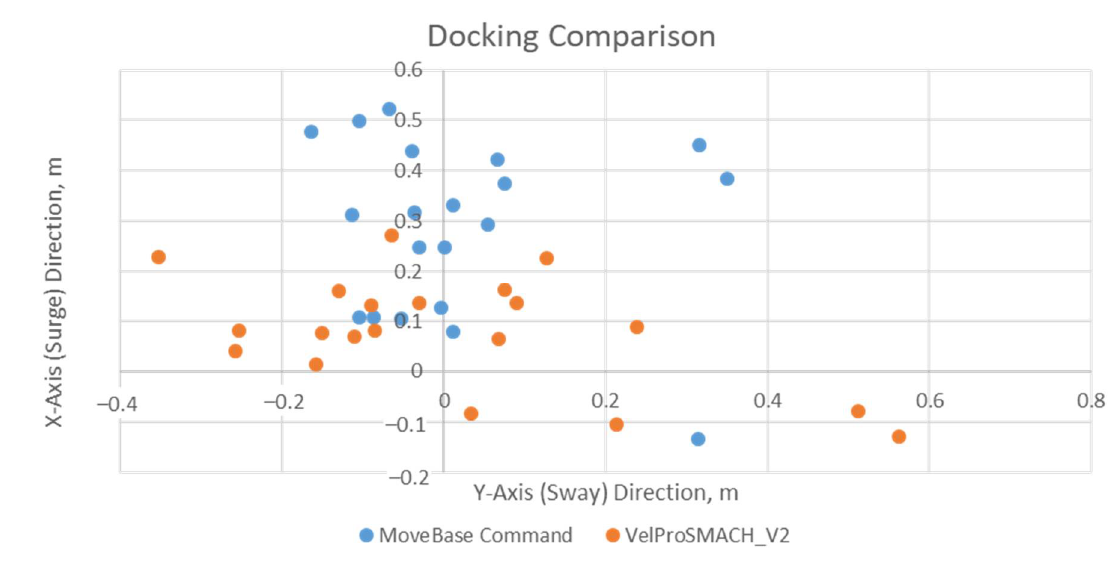
Figure 10. Docking accuracy using the move base command and S-velocity commands. Table 2. Performance result of MoveBase control .